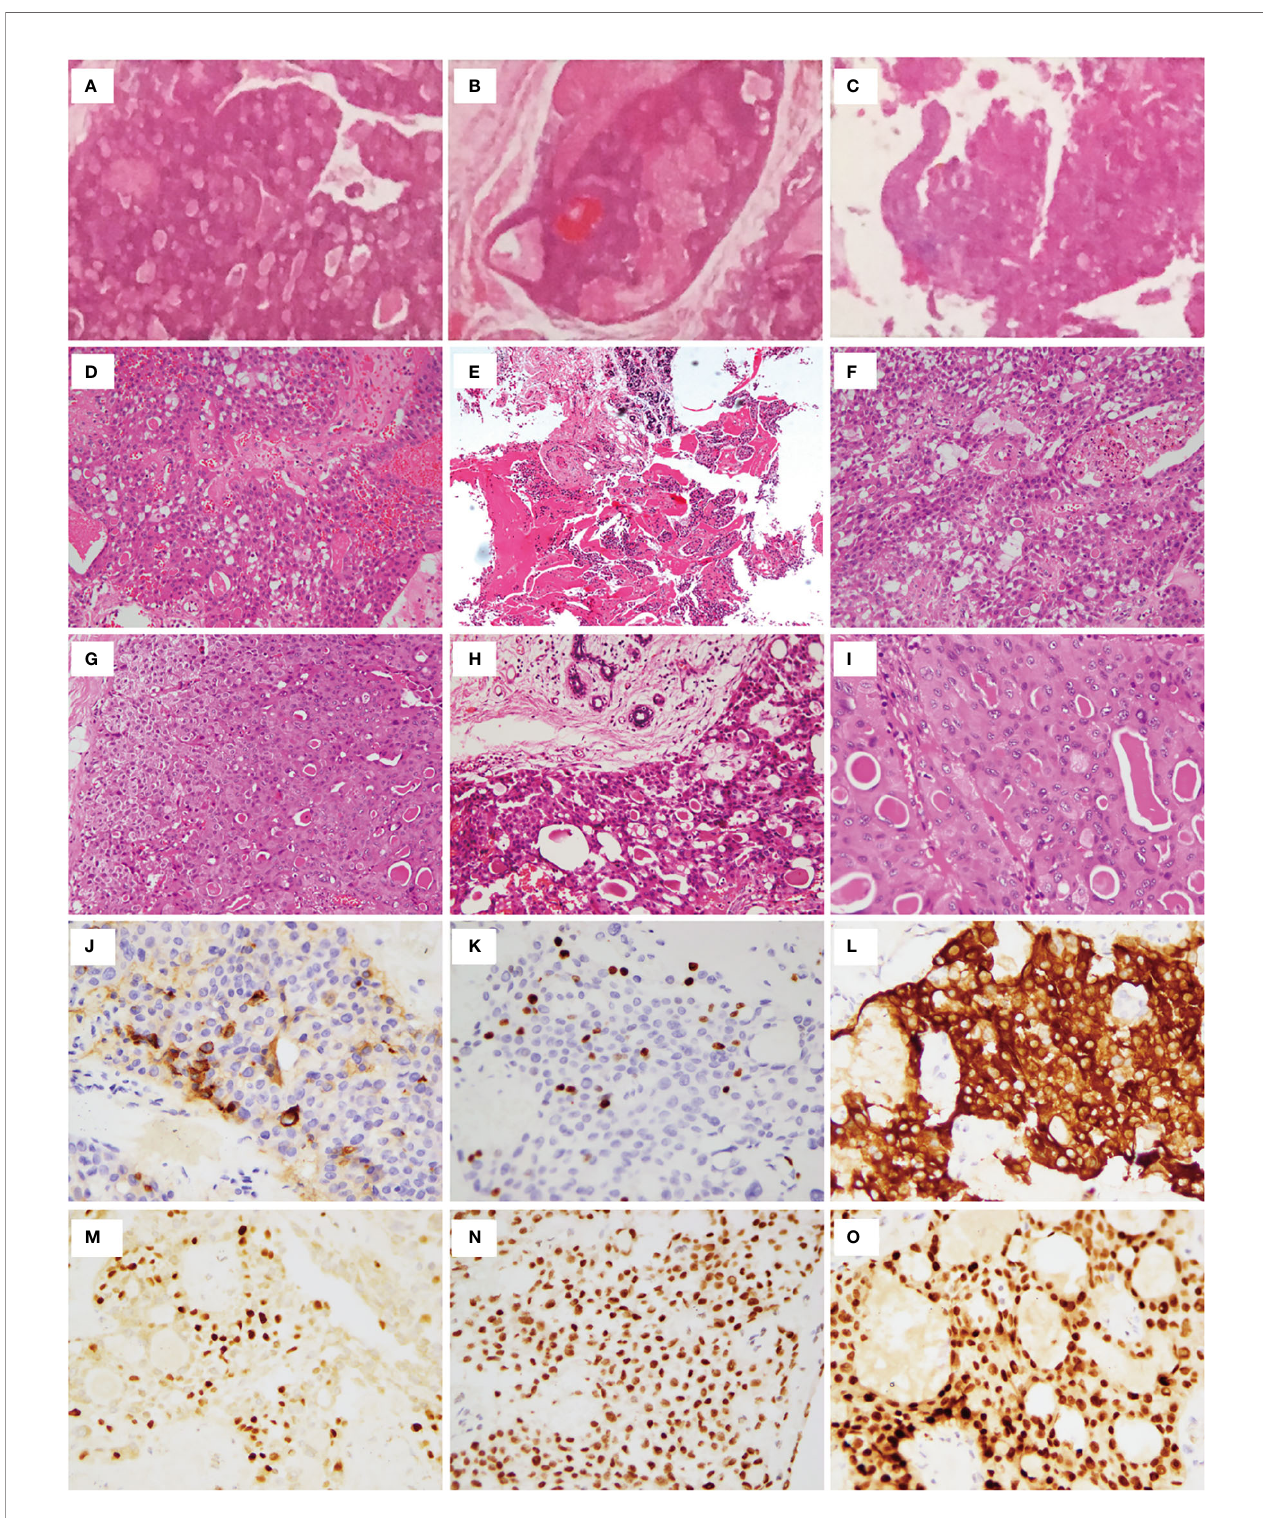
FIGURE 2 | Histopathologic examination. Postoperative pathologic examination of nodules in the chest wall showed that all nodules contained PTC tissues (A – C) . (D) Total thyroidectomy (in 2014) revealed PTC without reporting cell features. (E) lesion of right breast. Left lateral cervical (F) and left supraclavicular fossa (G) lymph node excision revealed metastatic PTC. Nodule of right chest wall (H) and Subcutaneous tissue of left neck (I) excision revealed metastatic PTC. (J) TG. (K) Ki67. (L) CK-19. (M) GATA-3. (N) TTF-1. (O)